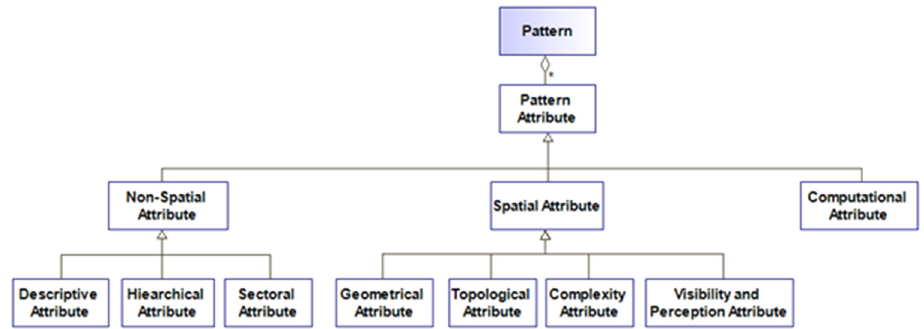
Figure 3. Types of SP attributes (UML class diagram).